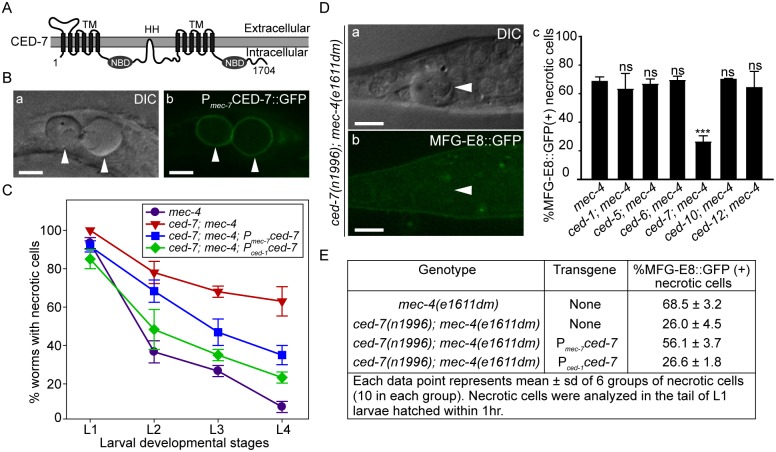
CED-7 promotes necrotic cell removal by acting in two different cell types.(A) CED-7 domain diagram. TM: transmembrane region (each has 6 transmembrane domains). HH: highly hydrophobic motif. NBD: nucleotide-binding domain. (B) CED-7::GFP expressed in necrotic cells is localized to cell surface. DIC (a) and corresponding epifluorescence (b) images of the tail of a newly hatched mec-4(e1611dm) L1 larva (hatched within 1hr) expressing Pmec-7
ced-7::gfp. Arrowheads mark two CED-7::GFP-positive necrotic corpses. Dorsal is to the top. Scale bars are 5μm. (C) Expression of ced-7 cDNA either in touch neurons or engulfing cells each partially rescues the necrotic cell removal defects. ced-7(n1996); mec-4(e1611dm) larvae expressing either Pced-1
ced-7 or Pmec-7
ced-7 were scored for the number of necrotic corpses in indicated larvae stages. Each data point represents the mean of 3 groups of 20 animals per group. Error bars represent sd. (D) CED-7 is required for PS exposure. (a) DIC and (b) the corresponding epifluorescence images of a necrotic cell (arrowheads) lacking MFG-E8::GFP signal on its surface in the tail of a L1 larva hatched within 1hr. Dorsal is to the top. Scale bar: 5μm. (c) Bar graph showing the percentage of necrotic cells on which the PS is detected by MFG-E8::GFP in newly hatched L1 larvae in different engulfment mutant backgrounds. Alleles used here: mec-4(e1611dm), ced-1(e1735), ced-6(n2095), ced-7(n1996), and ced-10(n1993). Each data point represents the mean percentage calculated from 6 groups of necrotic cells (10 in each group). Error bars represent sd. ns: no significant difference (p>0.05); ***, p<0.001, Student t-test. (E) The function of CED-7 in necrotic cells specifically rescues the PS-exposure defect of ced-7 mutants. The percent of necrotic cell corpses labeled by MFG-E8::GFP were scored in ced-7; mec-4 mutants expressing each transgene of Pmec-7
ced-7 or Pced-1
ced-7 individually.